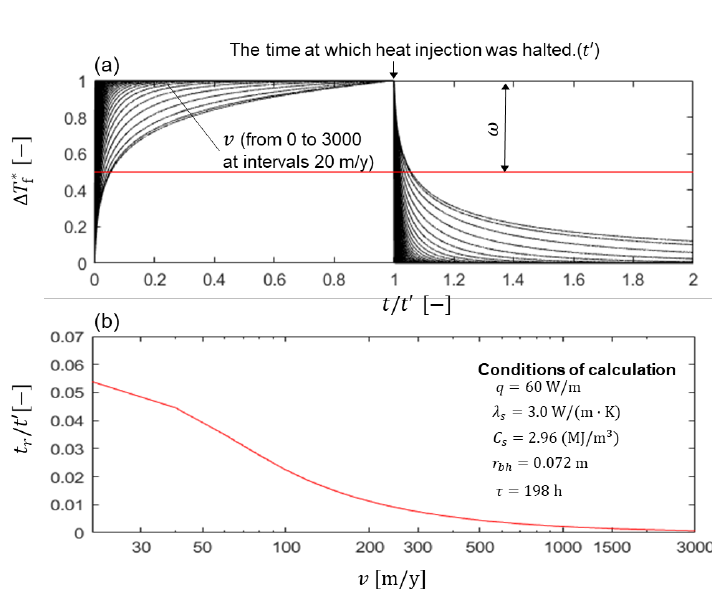
Figure 3. Relationship between the dimensionless temperature and the dimensionless relaxation time of temperature (RTT); ( a ) dimensionless temperature variation ( b ) dimensionless RTT according to the groundwater velocity.